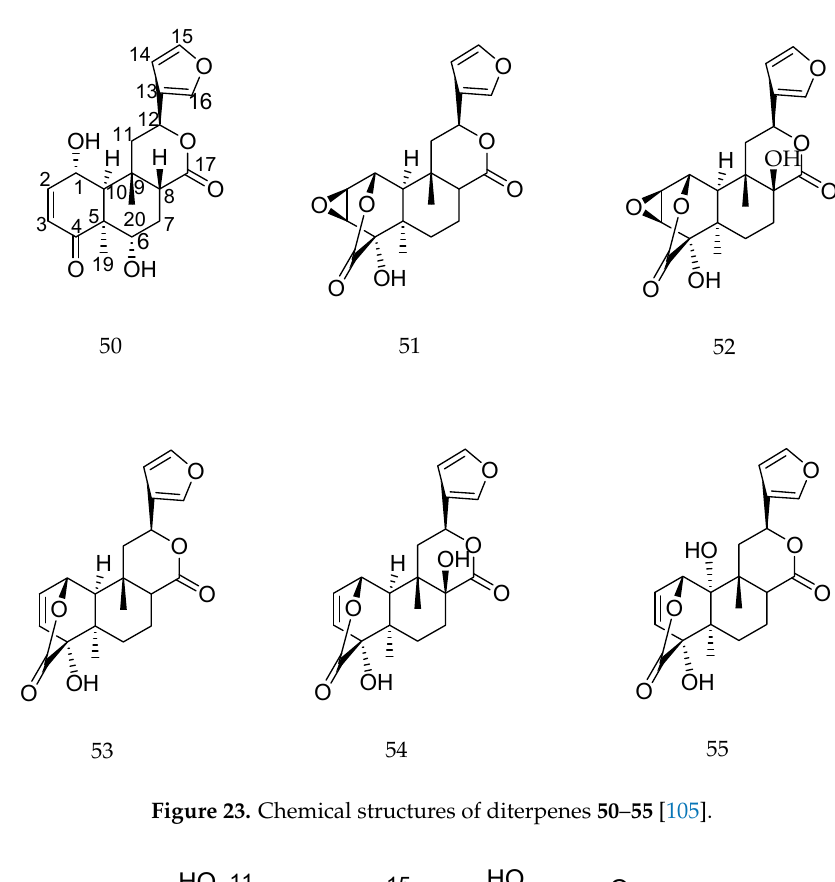
Figure 23. Chemical structures of diterpenes 50 – 55 [105].